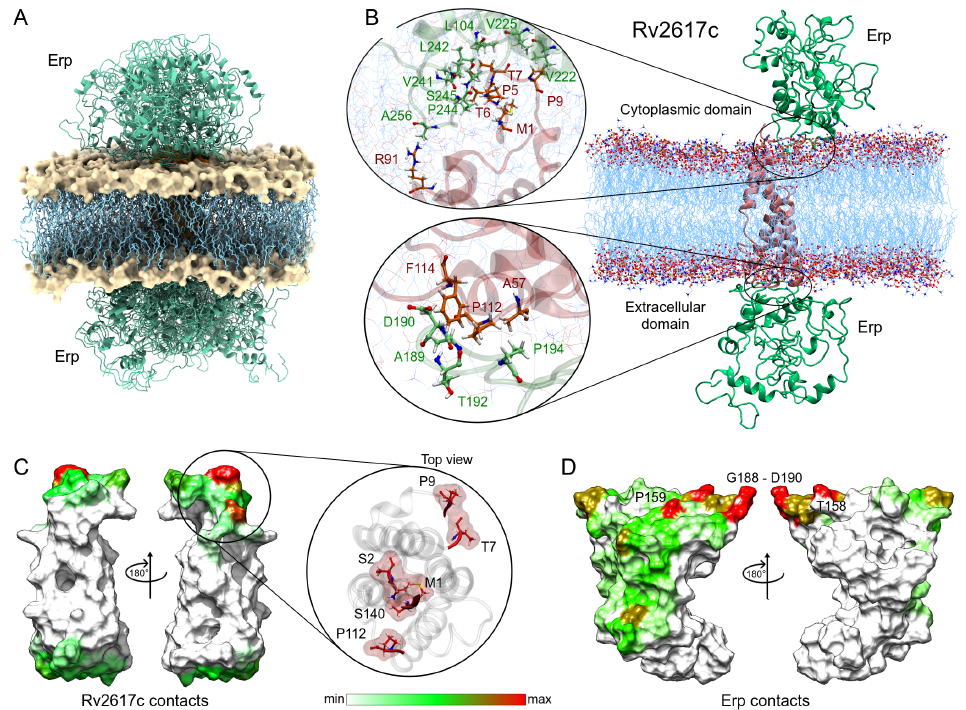
Figure 7. Analysis of the Erp–Rv2617c interactions. ( A ) Overall representation of the 19 energetically most favorable molecular complexes obtained in FireDock calculation with effective protein contact. ( B ) Contact analysis of the two energy best solutions on both sides of the lipid bilayer. Erp and Rv2617c residues are depicted in green and red–orange colors, respectively. ( C , D ) Heat map of the main contacts between the Rv2617c protein and Erp protein. The color scheme is the same as that in Figure